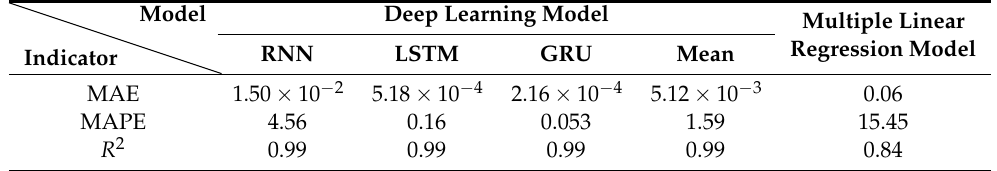
Table 4. Table of comparison between deep learning model and multiple linear regression.